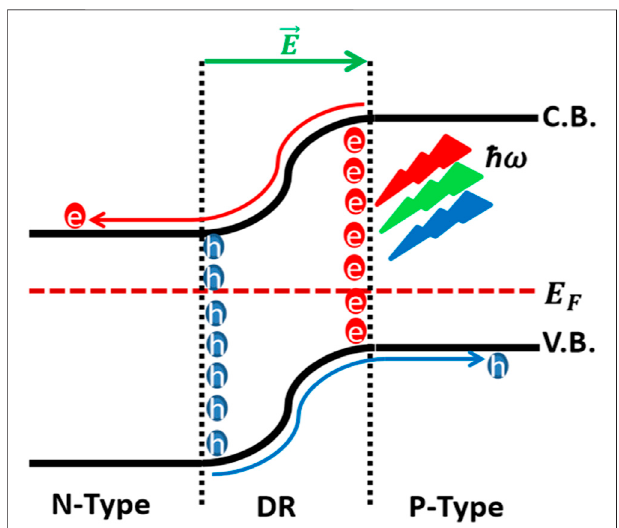
FIGURE 3 | Schematic band diagram of a solar cell device as a PN